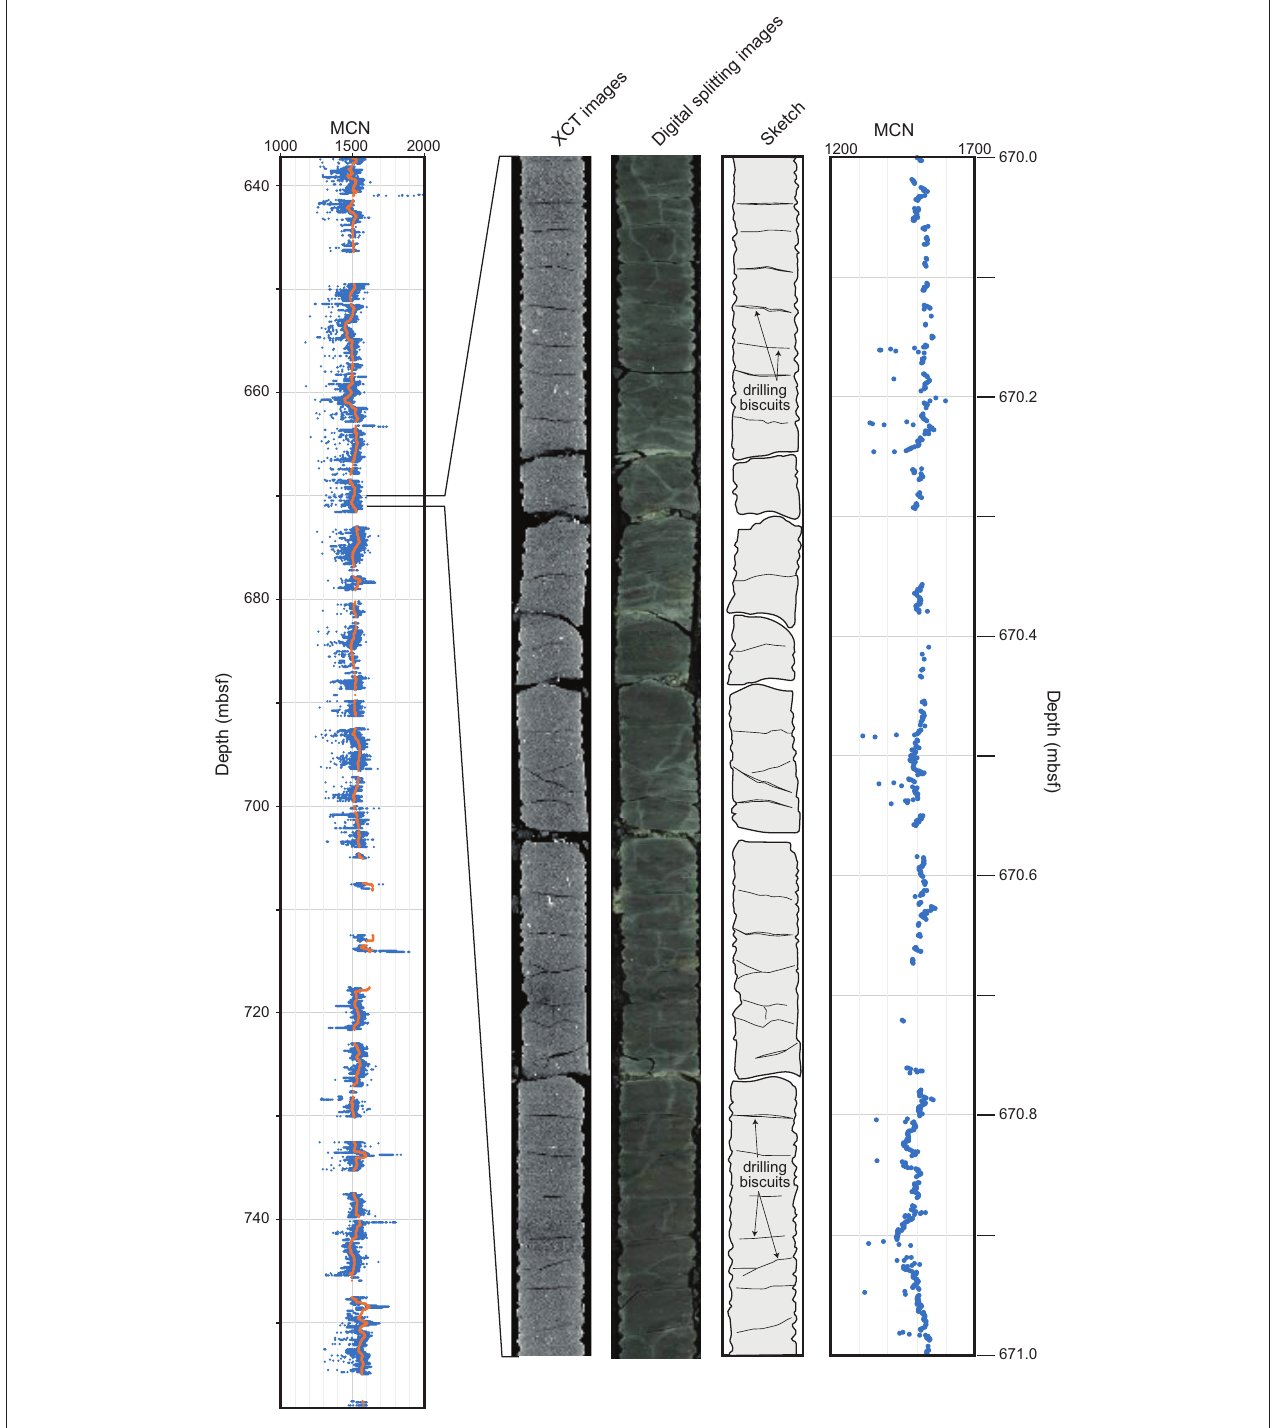
FIGURE 8 | Downhole quality-controlled MCN profile of the shallower part of the Lower Shikoku Basin facies (637.3–758.2 mbsf). Orange plots are 500-slices moving averages of MCN. Selected XCT images, digital splitting images, a sketch and a close up MCN profile of the interval where there are tiny negative anomalies corresponding to drilling biscuits are shown (from core C0023A-45R-2,